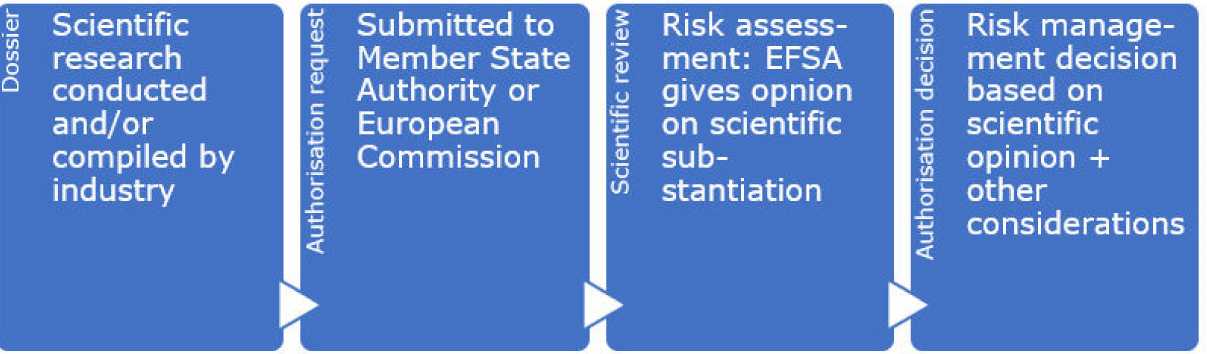
Figure 1. General process for authorisation requests for food and